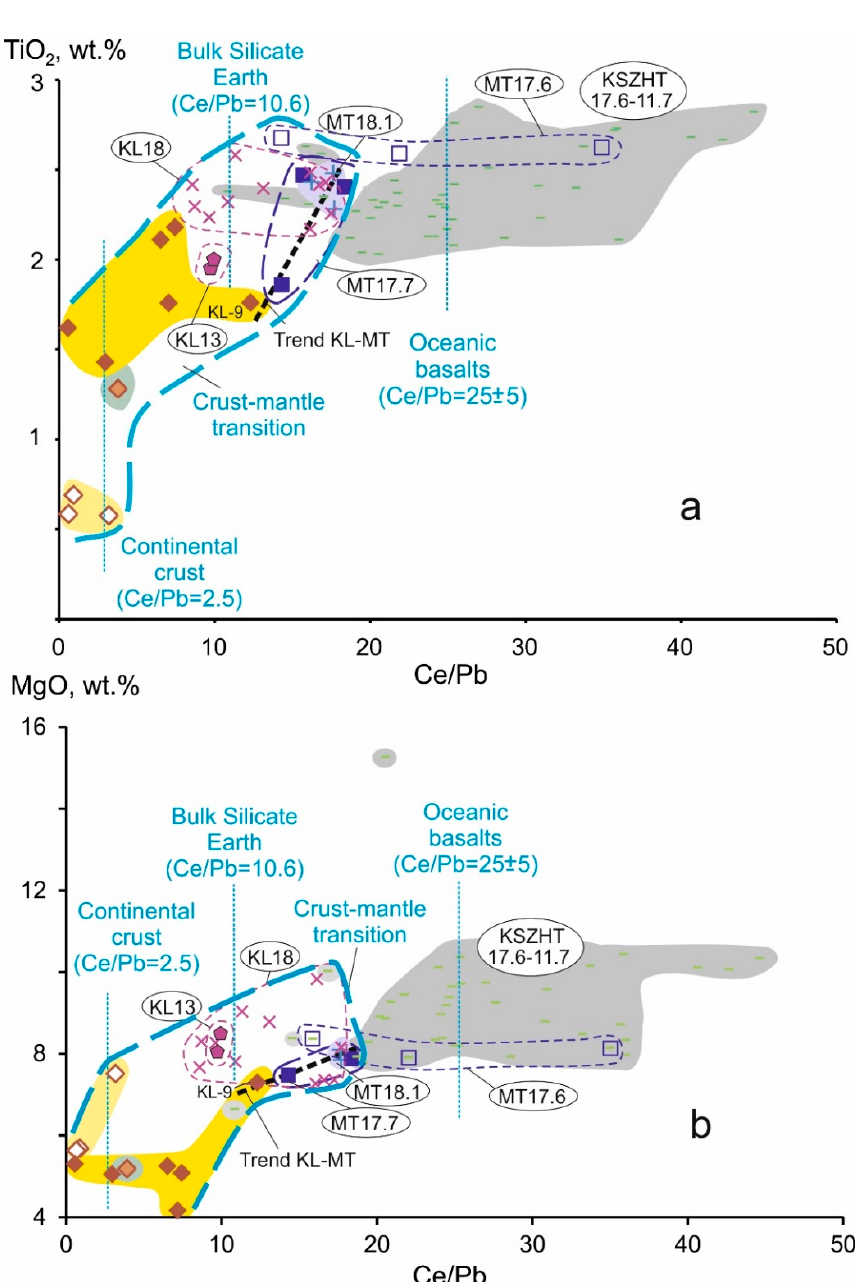
Figure 11. Comparison of basic pseudotachylytes from the MSF and volcanic rocks from the KSZHT on TiO 2 -Ce/Pb ( а ) and MgO-Ce/Pb ( b ) diagrams. Measured major oxide values are plotted. Designated as KL–MT are the common trends of pseudotachylyte KL-9 and lavas from the first two phases of the Meteo Volcano (MT18.1 and MT17.7). The Ce/Pb values for ocean basalts and continental crust are shown after [85], the Bulk Silicate Earth value is after [86]. Symbols are as in Figure 9.